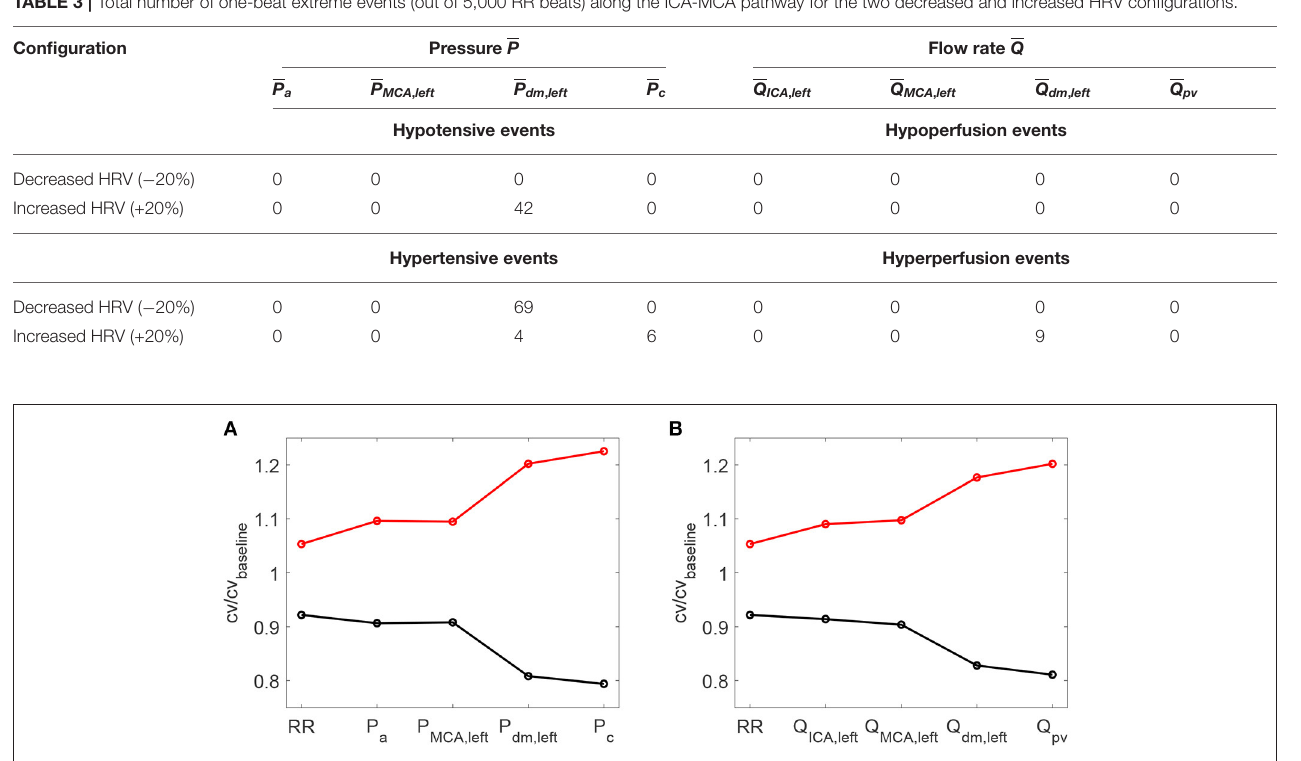
FIGURE 7 | Ratio between the coefficient of variation c v in increased/decreased (red/black) HRV cases and the coefficient of variation in baseline condition. Ratios for RR time-series and pressure/flow rate (A,B) continuous time-series along the ICA-MCA pathaway are